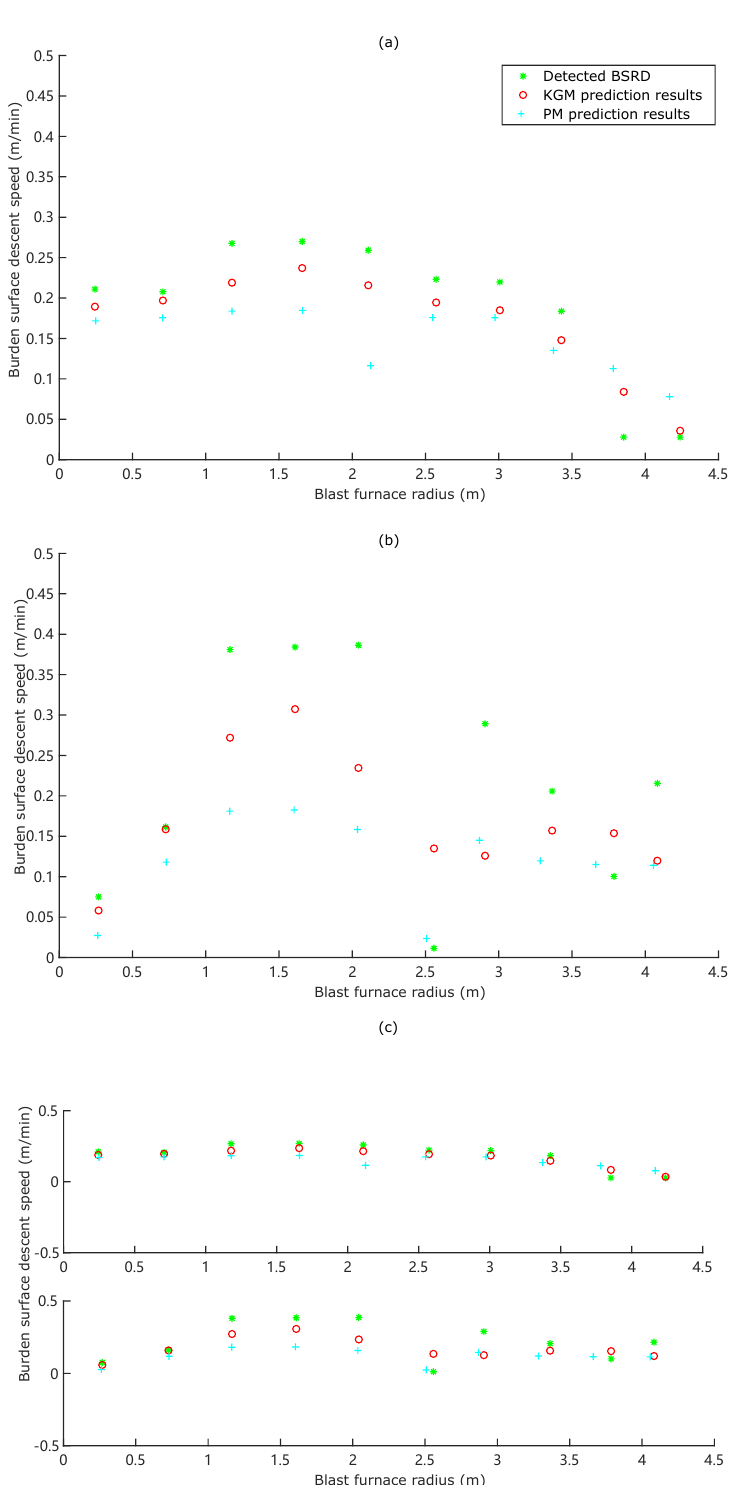
Figure 10. Comparison of BSRD prediction accuracy. ( a ) Results for Case 1; ( b ) results for Case 2; and ( c ) results presented on equal scaled axes. The upper subgraph corresponds to Case 1, and the lower one corresponds to Case